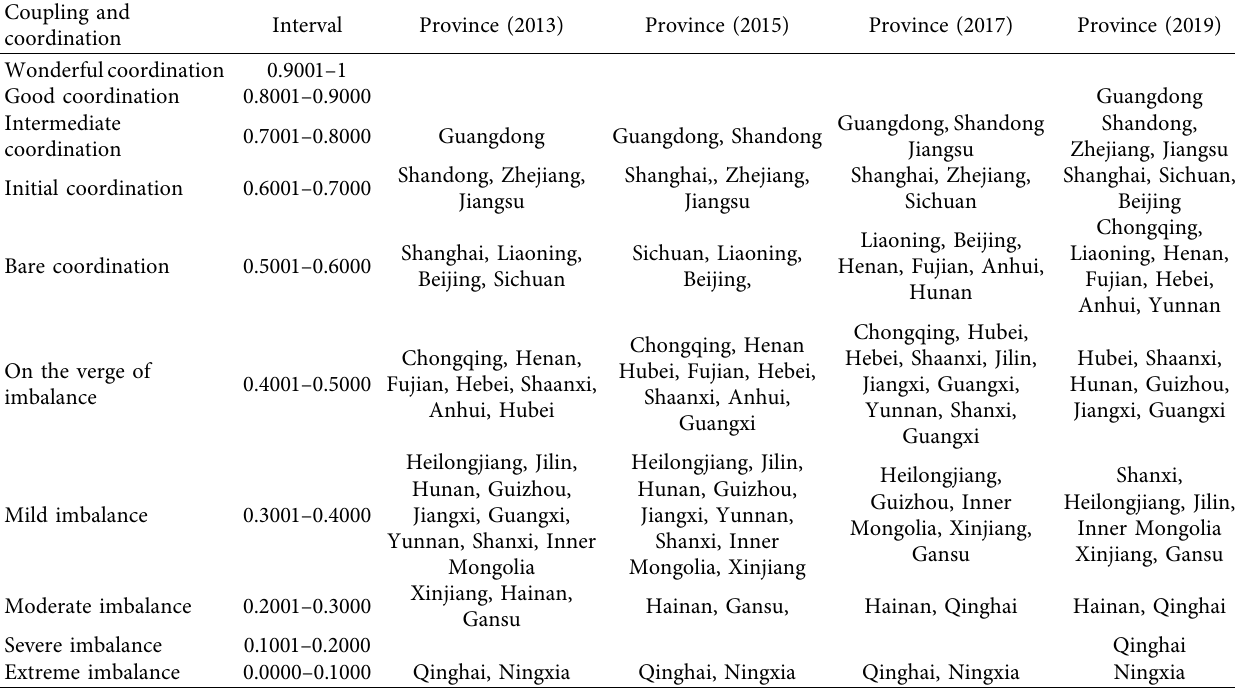
Table 2: The classification of coupling coordination degree of